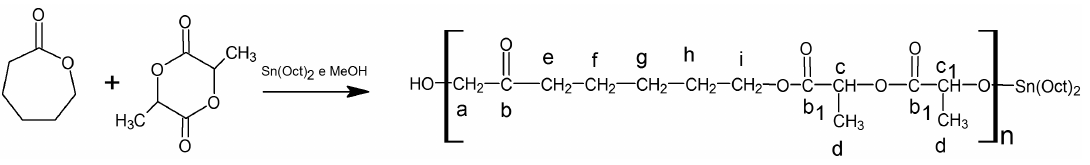
Figure 1. Chemical structure of PLLA-co-PCL copolymer with carbons marked for identification by 13 C-NMR.